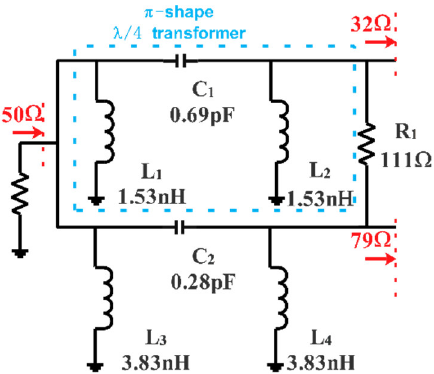
Figure 2. Proposed unequal split Wilkinson’s power divider.